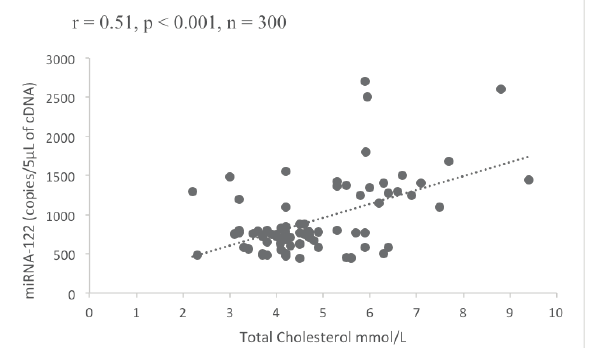
Figure 2: Correlation Graph of miRNA-122 with Total